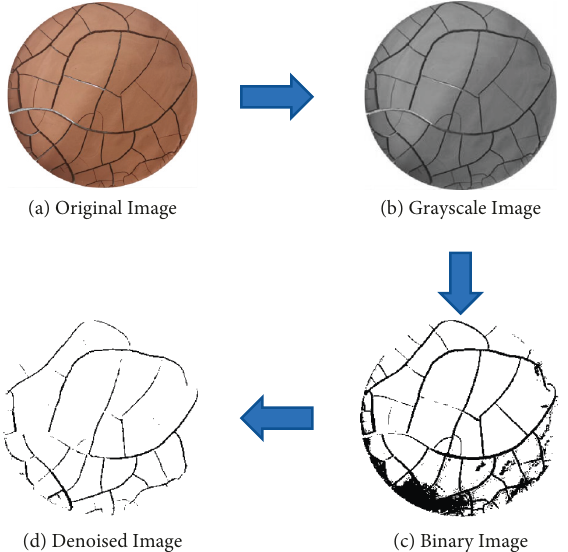
Figure 4: Image processing